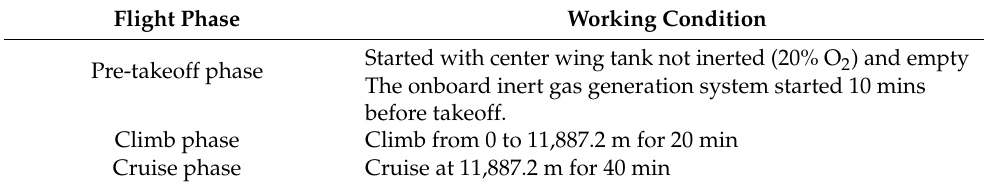
Table 2. Working conditions of the understudied flight phases in [7].